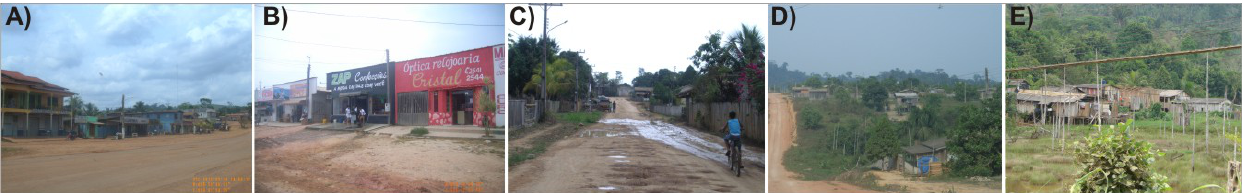
Figure 7. Spatial patterns verified within the units of human occupation categorized as Recent : ( A ) a road with a commercial center, ( B ) commercial establishments, ( C ) a peripheral street, ( D ) sparse housing occupation and ( E ) housing on stilts